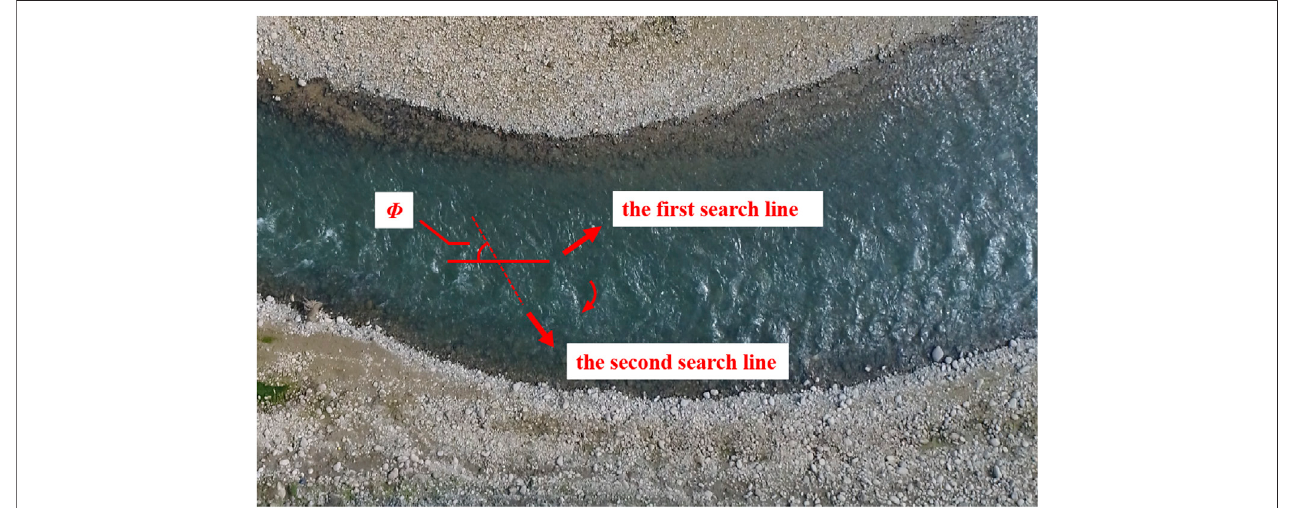
FIGURE 3 | A search line is rotated at one point to be measured from the horizontal in a UAV video and the rotating angle is Φ